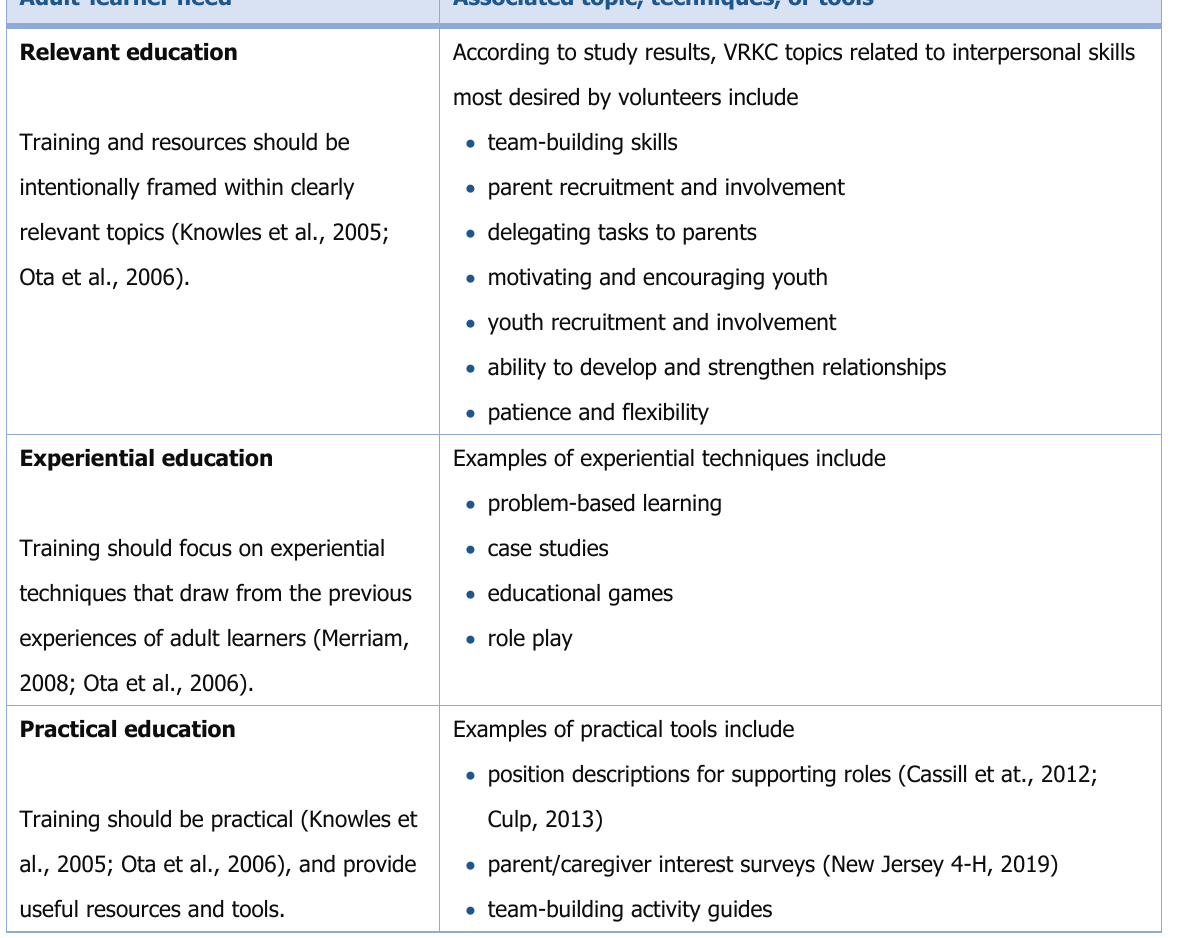
Table 12. Volunteer Education to Build Supportive